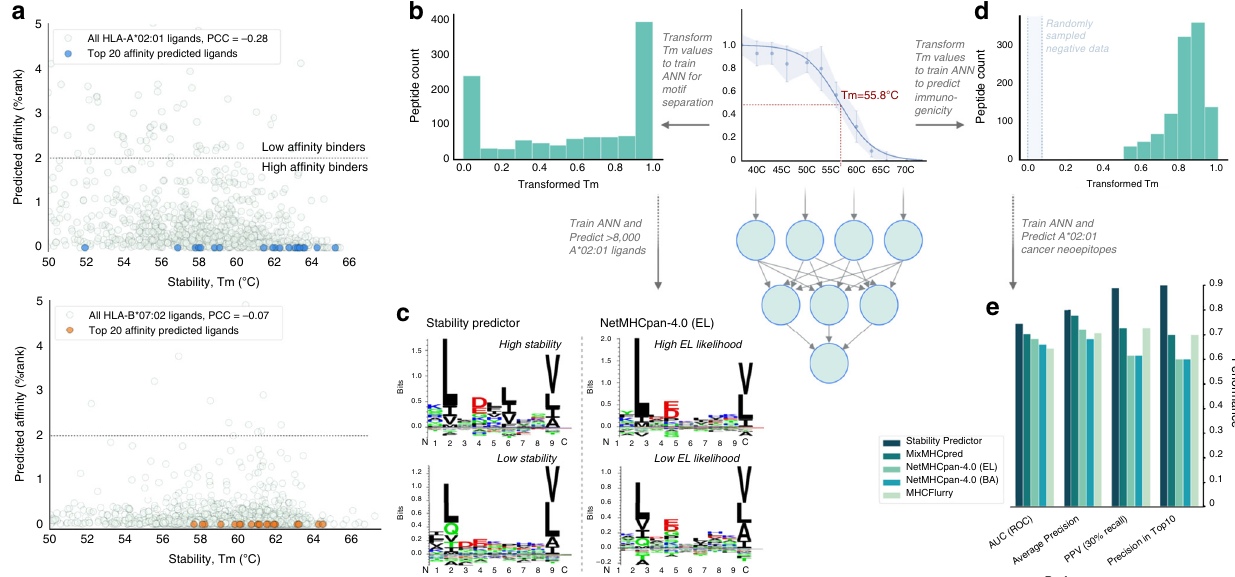
Fig. 3 Thermostability data of HLA-ligands improves immunogenicity prediction. a The information content of the stability data for each of the two main alleles studied (HLA-A*02:01 and HLA-B*07:02) was investigated by predicting peptide binding af fi nity with netMHCpan-4.0 (BA) 11 of the 8-11mer eluted ligands for which stability measurements were achieved demonstrating no correlation between predicted af fi nity and measured stability. Thus, granularity through peptide stability for predicted high-af fi nity HLA ligands was observed for both alleles. b T m values were calculated based on thermal melt curves for the identi fi ed peptides across 12 different temperature points ranging from 37 °C to 73 °C with n = 3 biological replicates at each temperature point. Thermal melt curve data are presented as median values ± SD. We trained an ANN model using transformed T m values as input for the identi fi ed 1094 peptides restricted by HLA-A*02:01. The resulting models were used to predict >8,000 allele-speci fi c eluted ligands. Binding motifs were constructed using the 1500 best and poorest predictions in both models. c This demonstrated a separation in the motif identi fi ed for high and low stability binders which could not be achieved using netMHCpan-4.0 (EL). d We investigated whether the additional dimensionality of the thermostability data could improve the prediction of immunogenic cancer neoepitopes by training ANNs with T m values rescaled to the interval [0.5;1] as positive training data and length-balanced, randomly sampled peptides from the human UniProt-Swissprot as negative training data. e The resulting Stability Predictor demonstrates superior performance to current prediction tools with 9 of the predicted peptides in the top 10 being true neoepitopes (Precision in Top10). BA: binding af fi nity. PCC: Pearson Correlation Coef fi cient. EL: eluted ligand. AUC: Area Under the Curve. ROC: Receiver Operating Characteristic. PPV: Positive Predictive